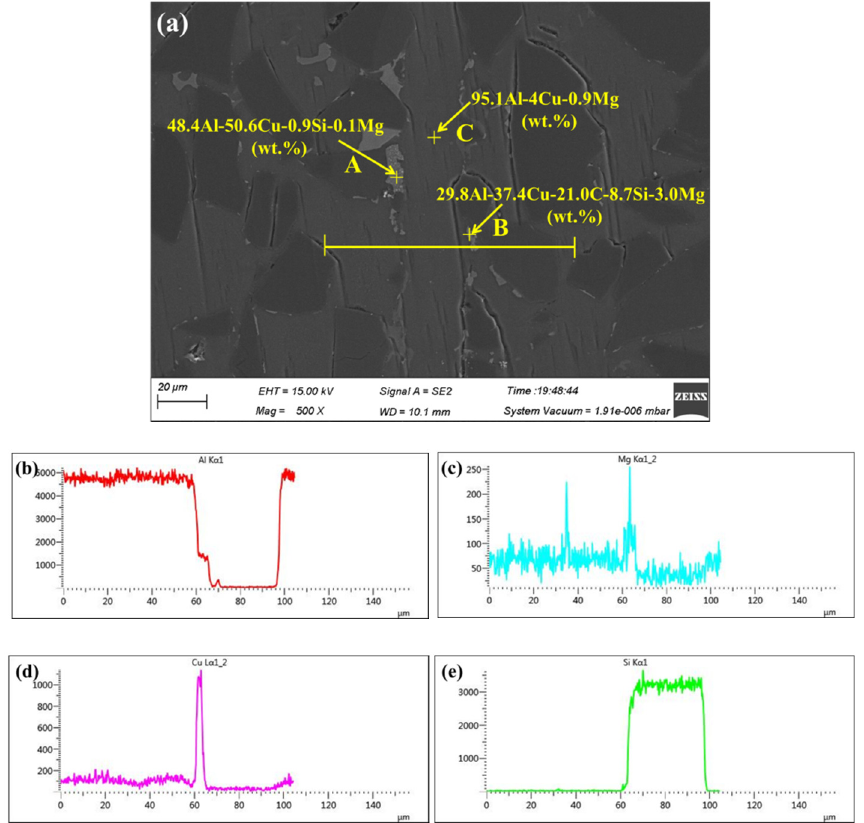
Figure 10. SEM image of a typical region at the interface of the 55 vol.% SiC p / ZL102 composite joint made at 580 °C and corresponding energy dispersive X-ray analysis: ( a ) SEM image; ( b – e ) individual elemental line scanning profile of Al, Mg, Cu, and Si, respectively.